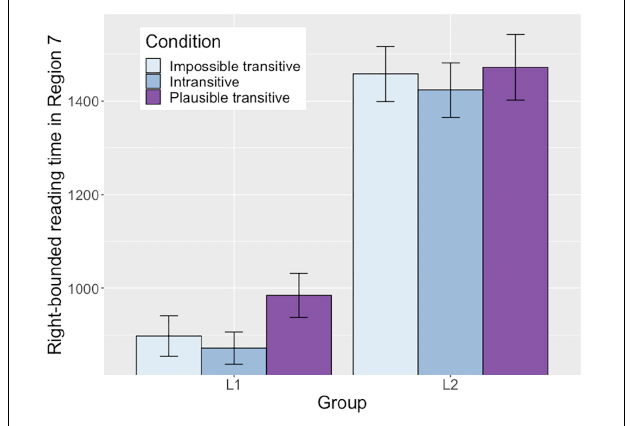
FIGURE 2 | Right-bounded reading time in Region 7 in each condition in each